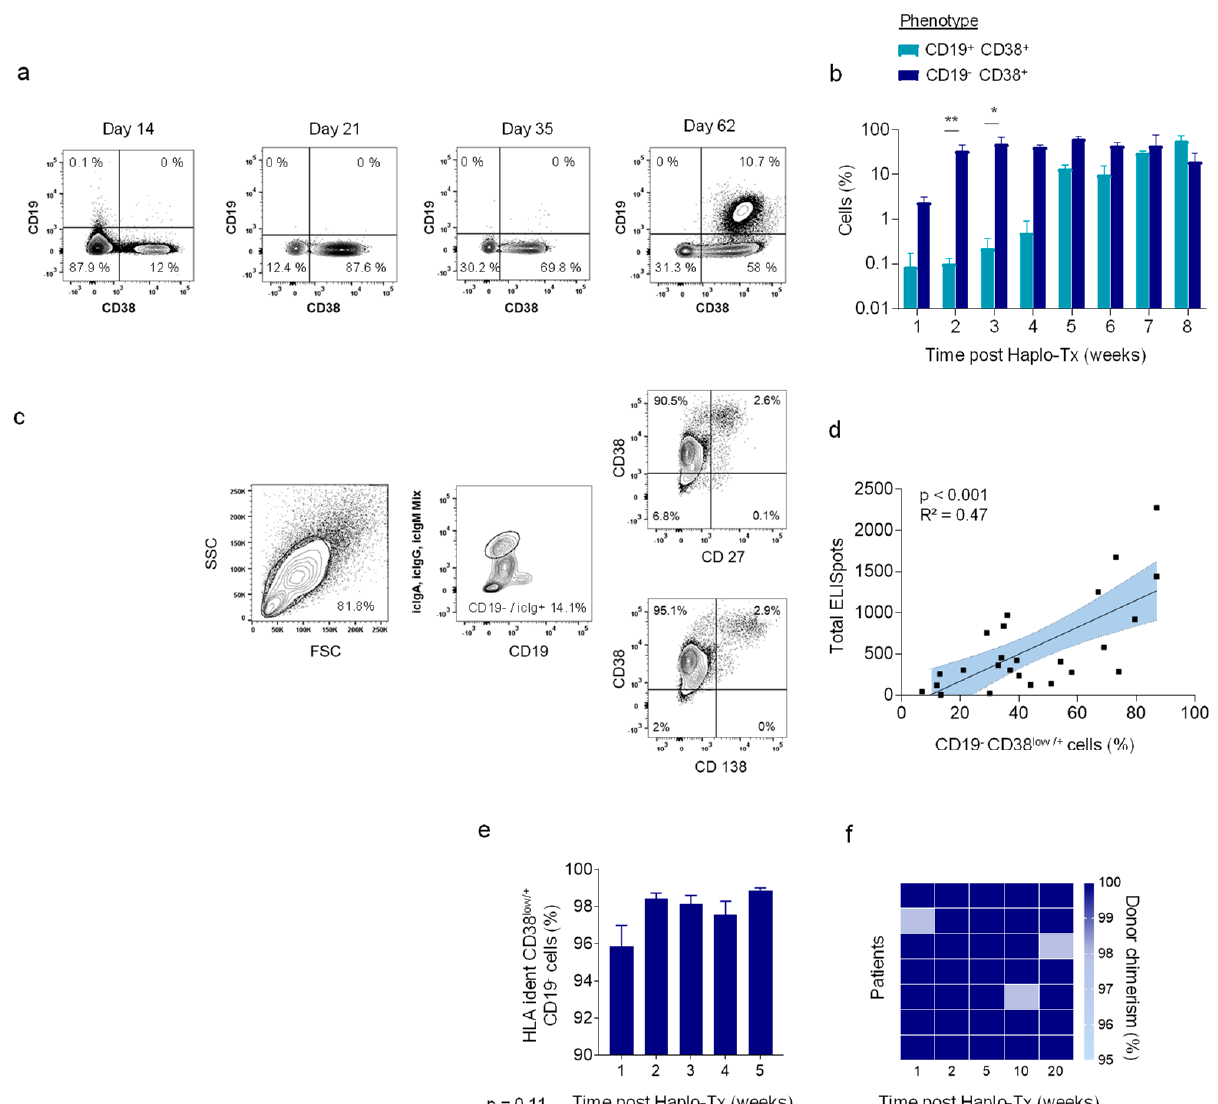
Figure 2. Reconstitution of B cells and antibody secreting cells (ASC). ( a ) Representative flow cytometry gating showing reconstitution of CD19 and CD38 positive immune cells. ( b ) Quantitative analysis of CD19 + CD38 + and CD19 − CD38 + immune cell populations in week 1–8 after HHCT. ( c ) Identification of immature IgM, IgA and IgG presenting CD38 low/+ CD19 − CD27 − CD138 − cells two weeks after HHCT. ( d ) Linear regression analysis of total number of ELISpots (IgM, IgG and IgA) and frequency of CD38 low/+ CD19 − cells in % of total PBMCs ( p < 001, R 2 = 0.47). ( e ) Frequency of CD38 low/+ CD19 − cells presenting donor HLA phenotype ( p = 0.11). ( f ) Donor chimerism of all patients